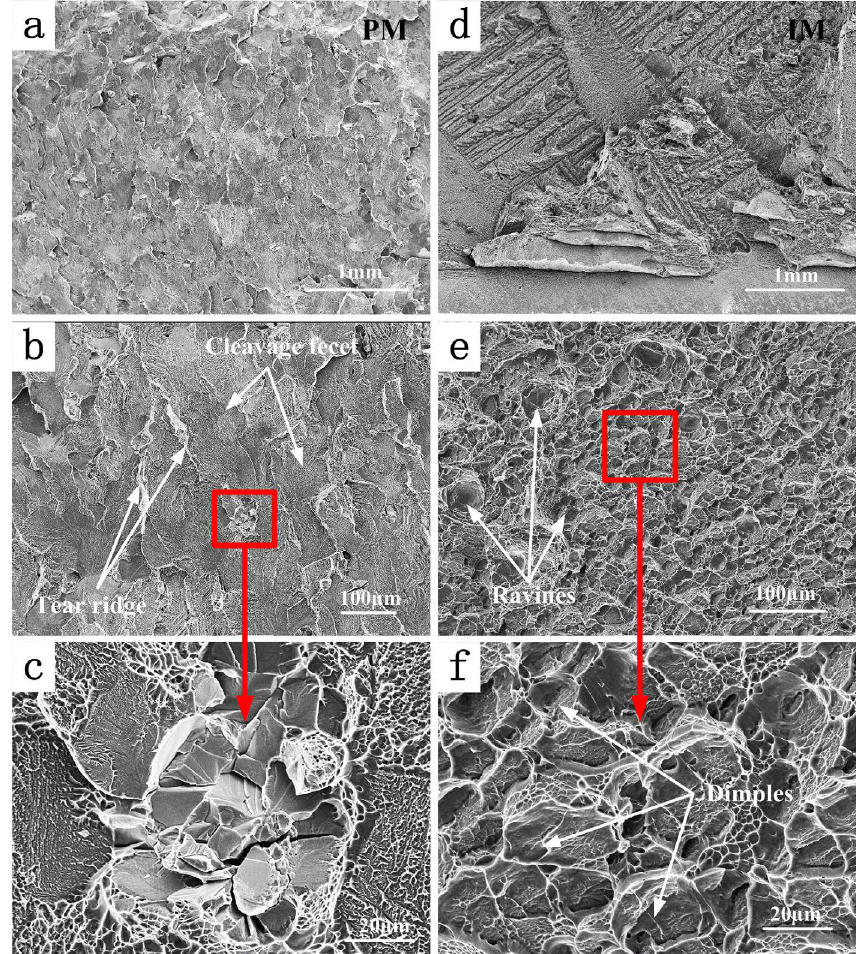
Figure 4. SEM images of macroscopical scale and microscopical scale fracture surface morphologies of the specimens after impact toughness tests of as-consolidated PM and as-cast IM Ti-5553 alloys: (a) PM macroscopical scale; (b) and (c)PM microscopical scale; (d) IM macroscopical scale; (e) and (f) IM microscopical